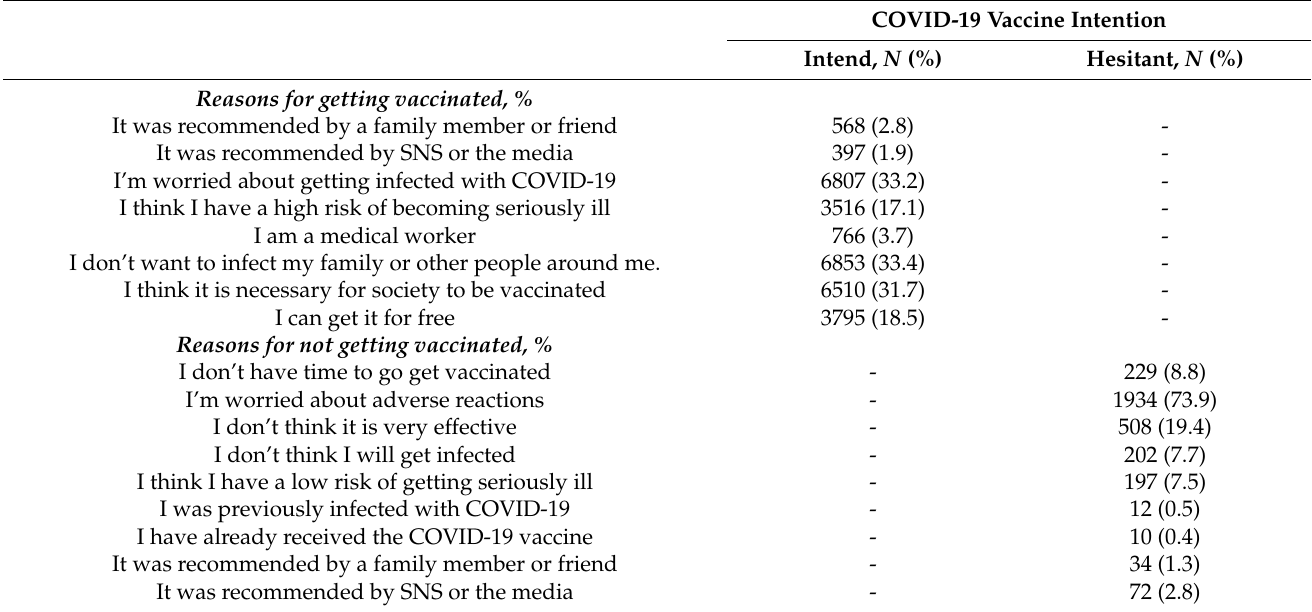
Table 3. Reasons for getting vaccinated and not getting vaccinated against COVID-19.